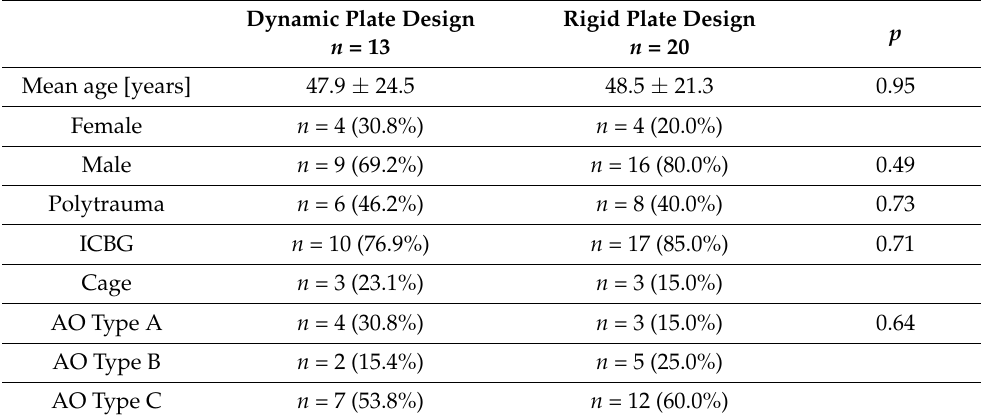
Table 1. Distribution of patient data, surgery information and fracture